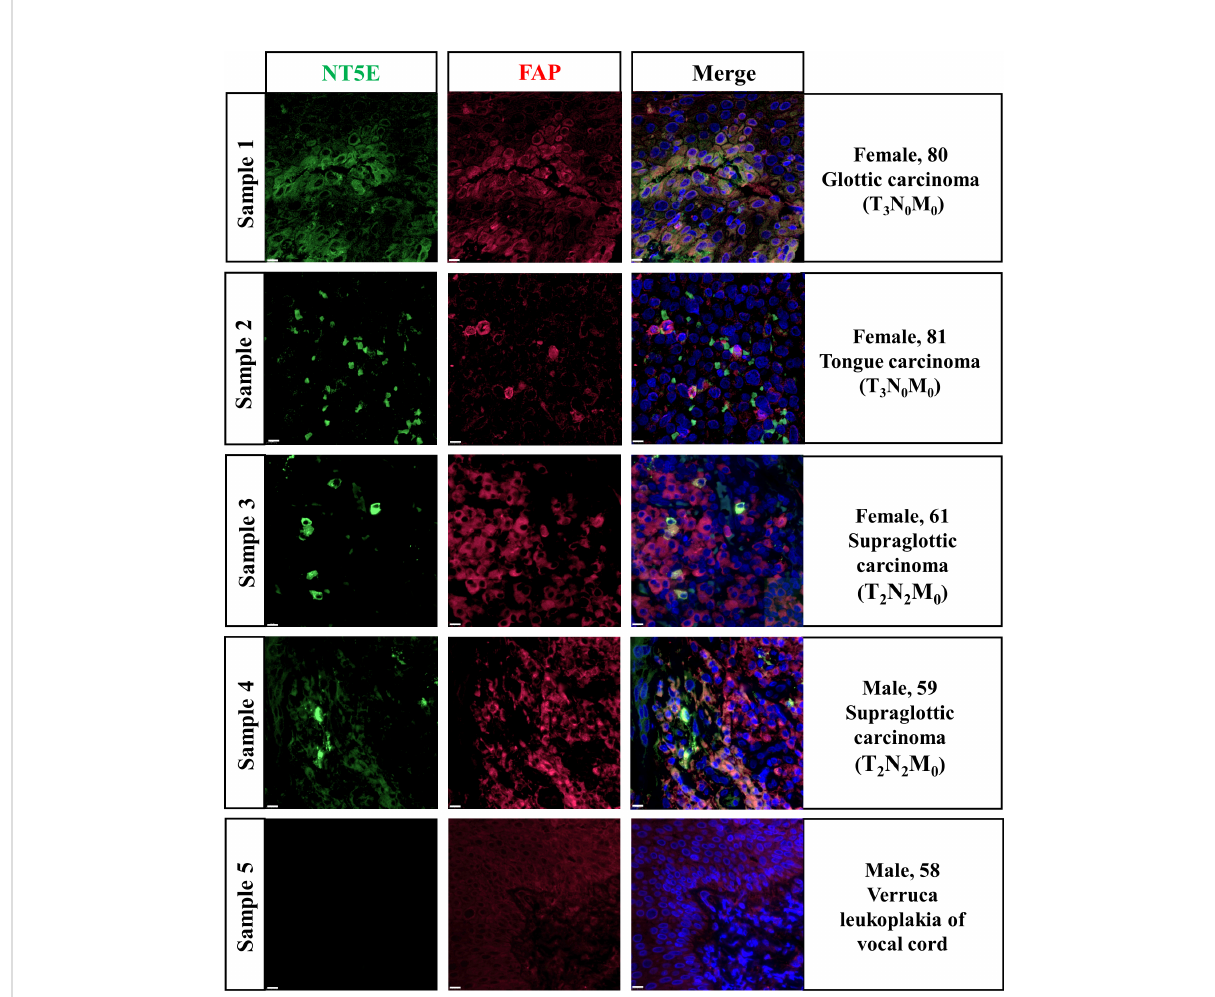
FIGURE 7 Validation of NT5E expression pattern on HNSC specimens.Scale bar =10 m m. Green stands for NT5E expression, red stands for FAP expression, and blue stands for nuclear staining by